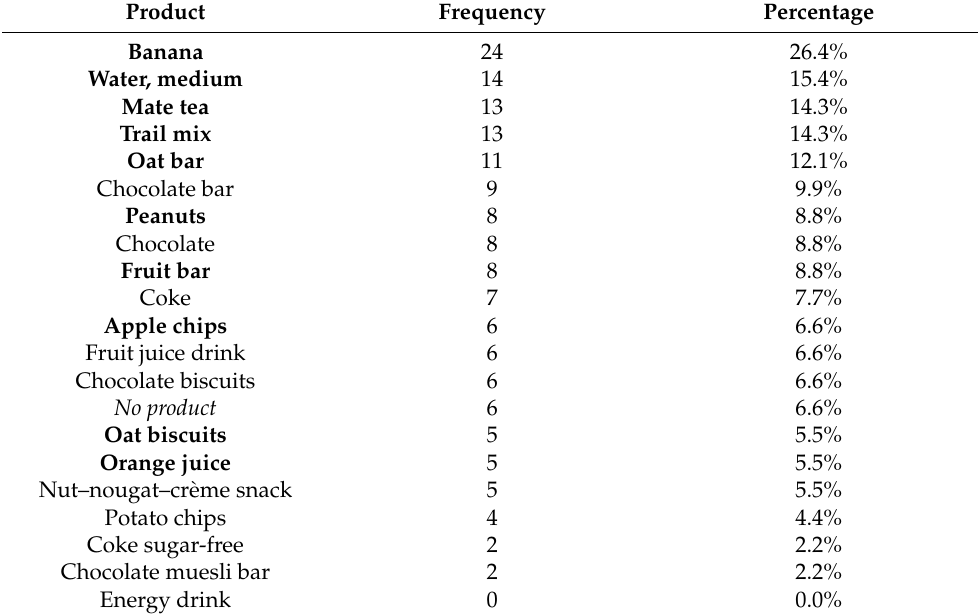
Table 3. Frequency and percentage of the chosen